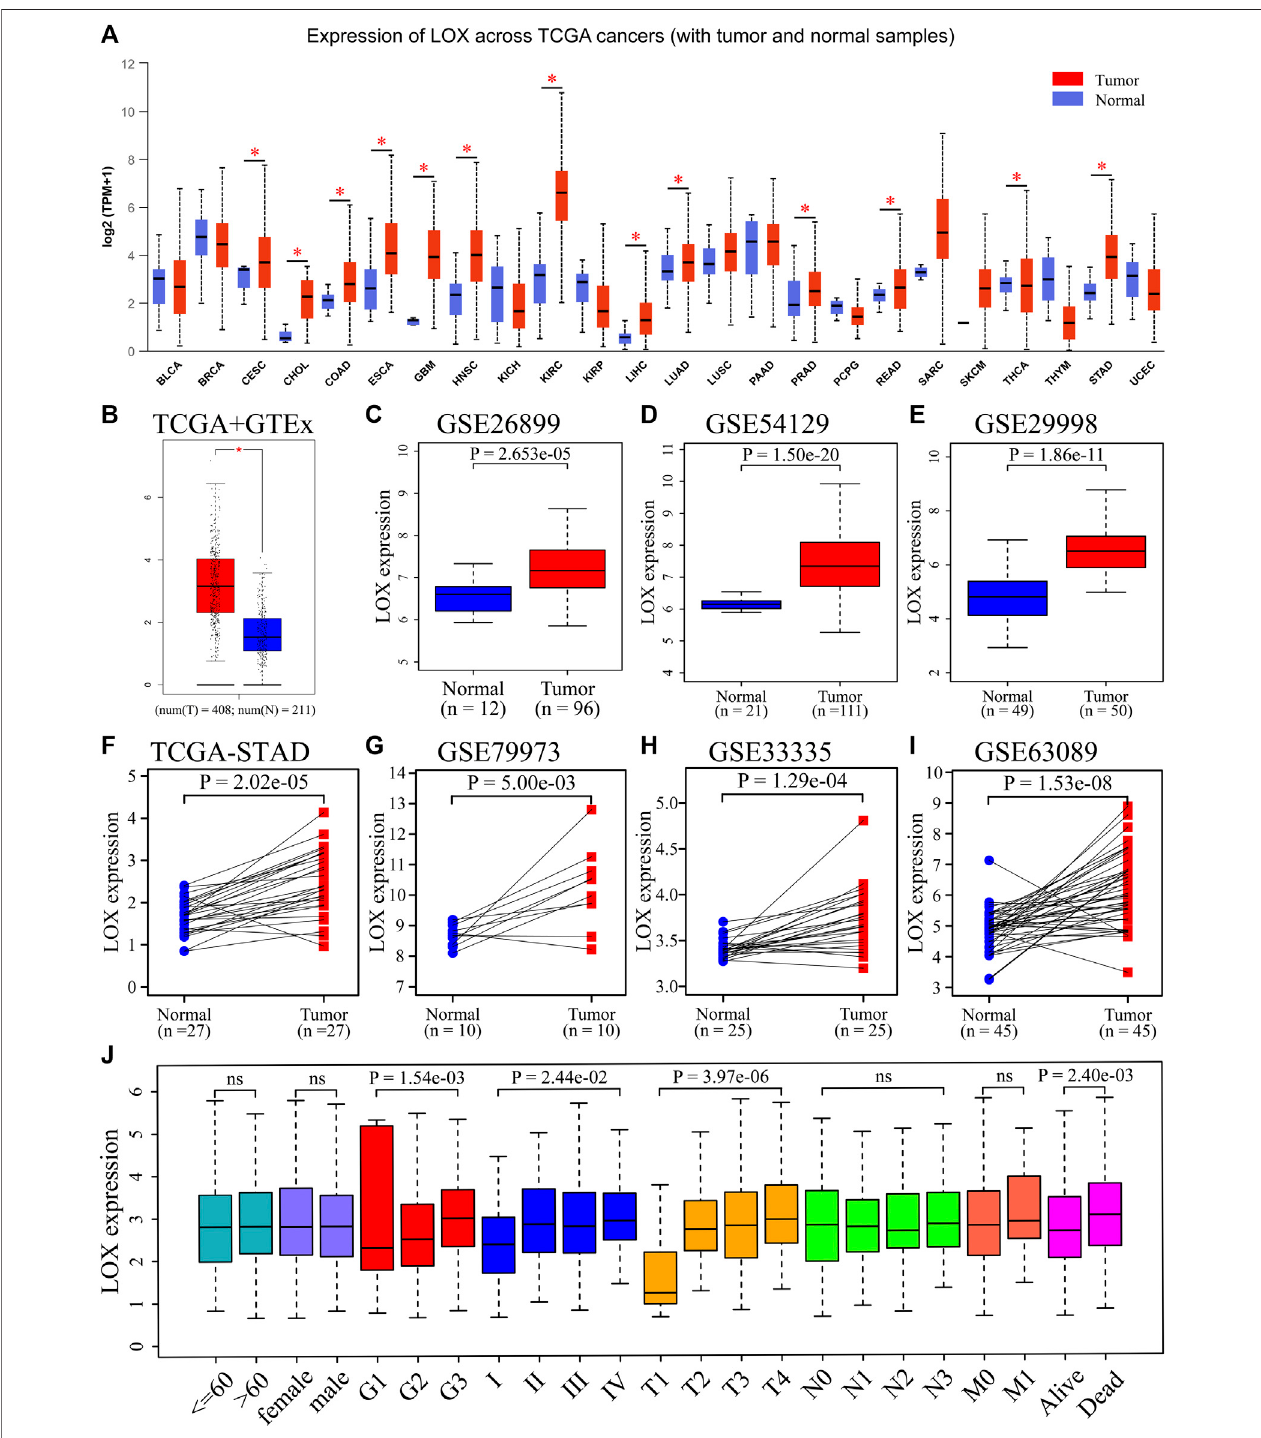
FIGURE1 | The mRNA oflysyl oxidase(LOX) is overexpressed ingastric cancer. (A) Pan-cancer analysis ofLOX mRNA expression acrosscancersfrom UALCAN dataset. (B) LOX mRNA expression levels in stomach adenocarcinoma (STAD) and normal tissues in The Cancer Genome Atlas (TCGA) + GTEx dataset. (C – E) LOX mRNA expression levels in STAD and normal tissues in GSE26899 (C) , GSE54129 (D) , and GSE29998 (E) datasets. (F) LOX mRNA expression in STAD and matched normaltissuesinTCGAdataset. (G – I) LOXmRNAexpressioninSTADandmatchednormaltissuesinGSE79973 (G) ,GSE33335 (H) ,andGSE63089 (I) datasets. (J) The correlation between LOX mRNA expression and clinicopathological parameters of STAD patients from TCGA database. ns, no signi fi cance; * p < 0.05.